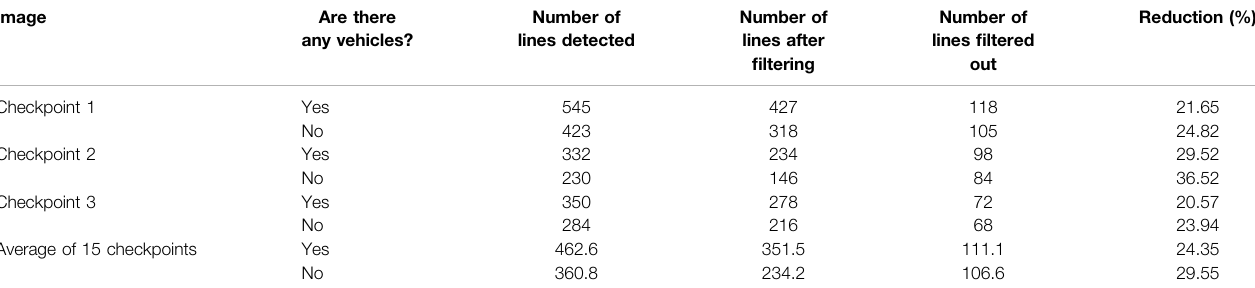
Number of lines detected